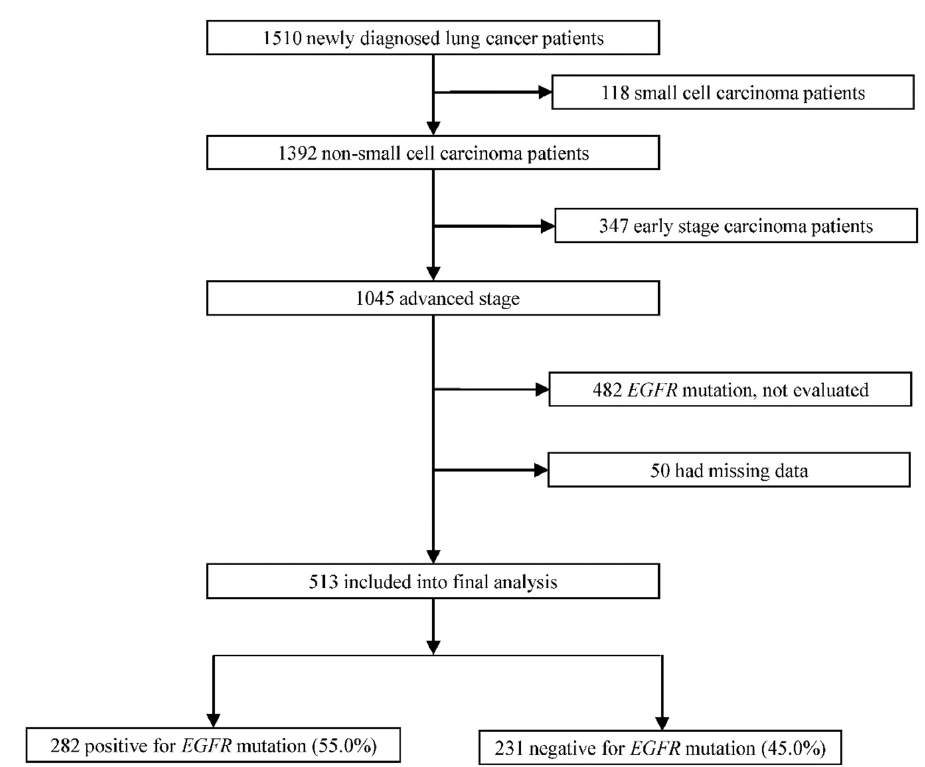
Figure 1. The flow diagram depicting the patient’s enrollment scheme. Table 1. Clinical characteristics of study patients ( n = 513).